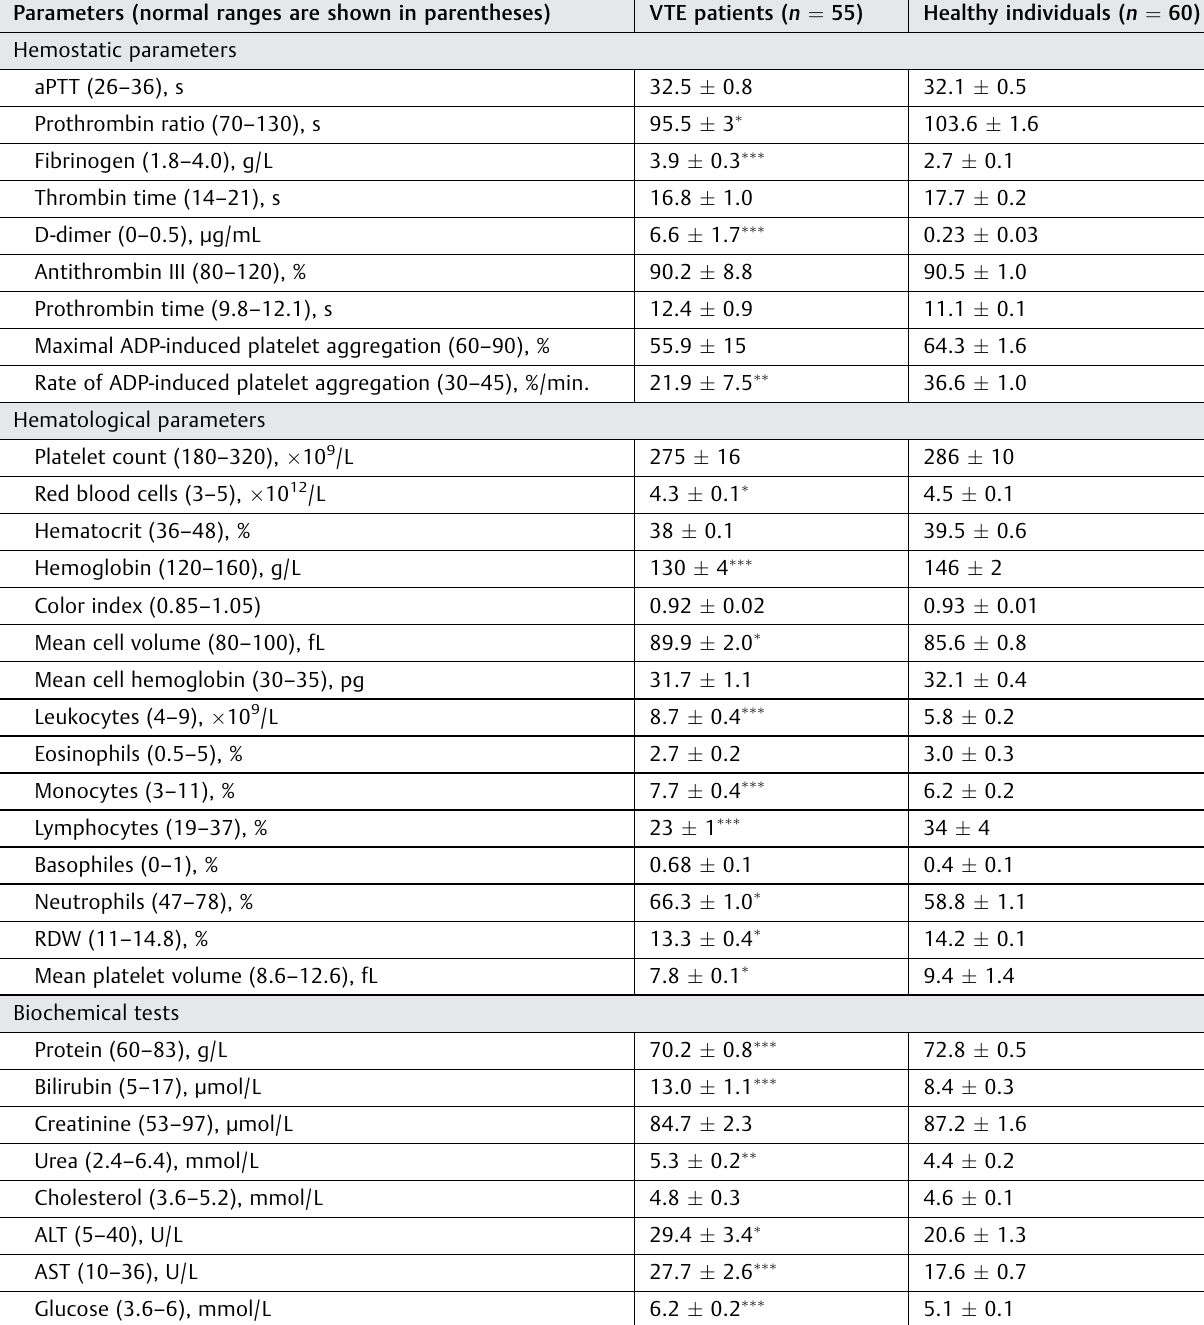
Table 2 Laboratory test results in VTE patients and healthy donors Parameters (normal ranges are shown in parentheses) VTE patients ( n ¼ 55) Healthy individuals ( n ¼ 60) Hemostatic